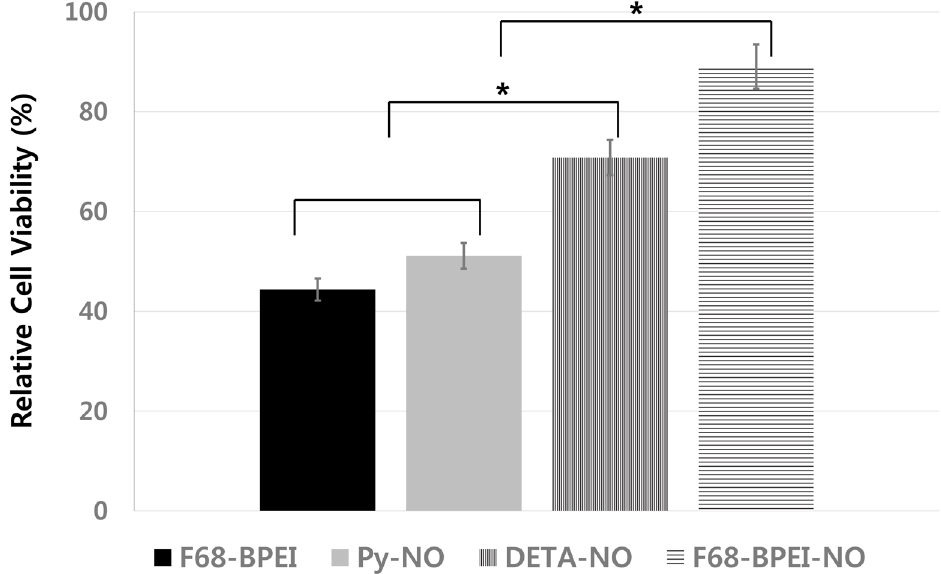
Fig 3. Cytotoxic effects of NO-releasing compounds on HGF-1 cells. The bactericidal assay showed that the minimum concentrations of NO-releasing compounds required to kill all pathogens within 24 h were 2, 1, 25, and 1.56 mM for F68-BPEI, F68-BPEI-NO, Py-NO, and DETA-NO, respectively. The cell viability in each group was calculated by comparing the viability with that of an untreated control (100%). Asterisks indicate significant differences ( P < 0.05) between